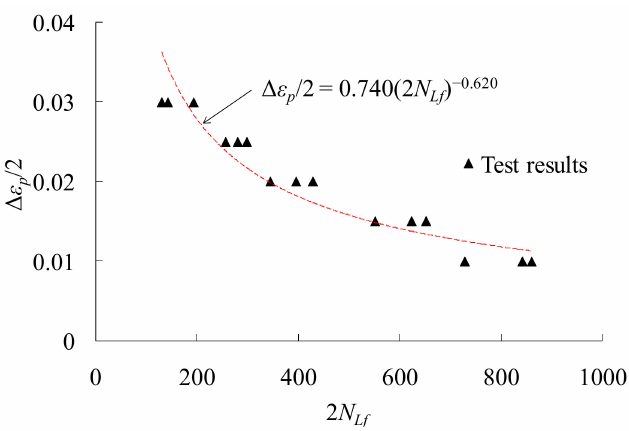
Figure 4. Low cycle fatigue test results and the fitting equation. The damages caused by different amplitudes of LCF load can be counted using the Miner’s rule